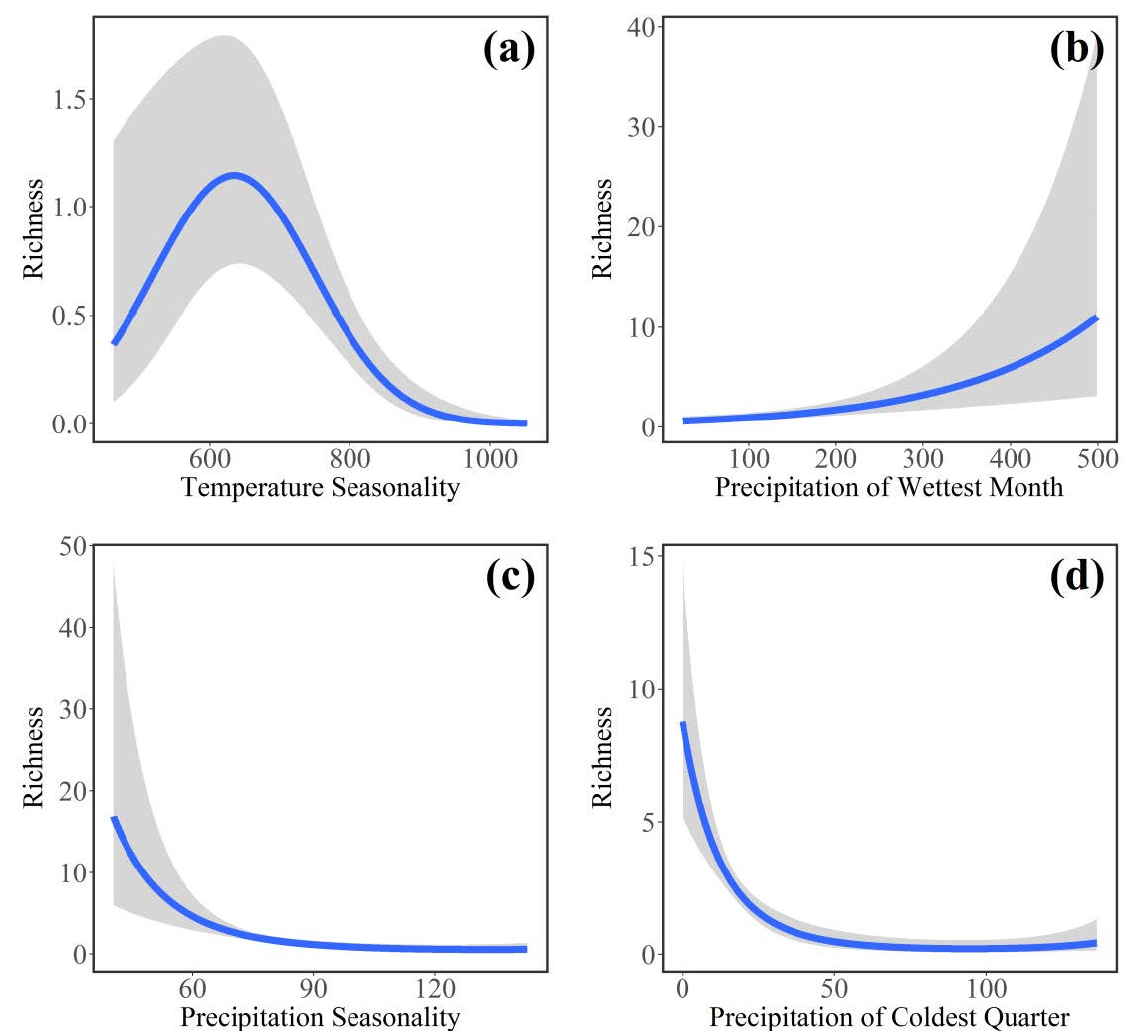
Figure 8. The relationship between four important factors selected by the random forest model and non-native fish richness. The gray range is the 95% confidence interval. ( a ) Bio4: temperature seasonality; ( b ) Bio13: precipitation of wettest month; ( c ) Bio15: precipitation seasonality; ( d ) Bio19: precipitation of coldest quarter.